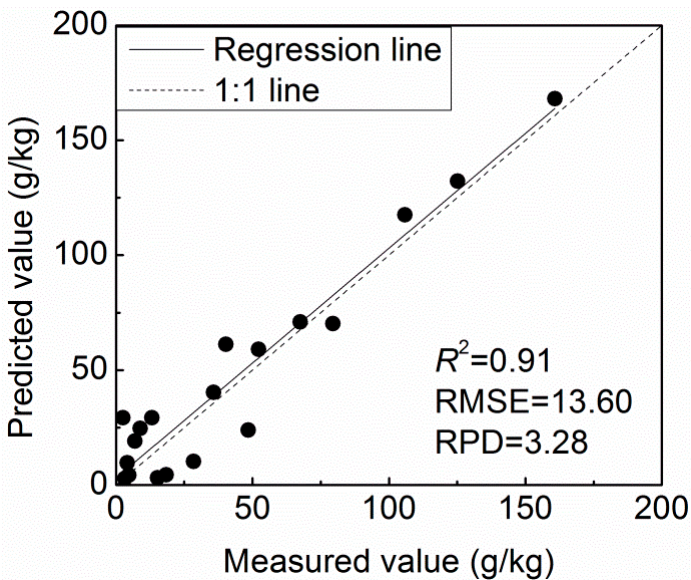
Figure 5. Comparison of estimated and measured values of SOM content by stepwise multiple linear regression (SMLR).